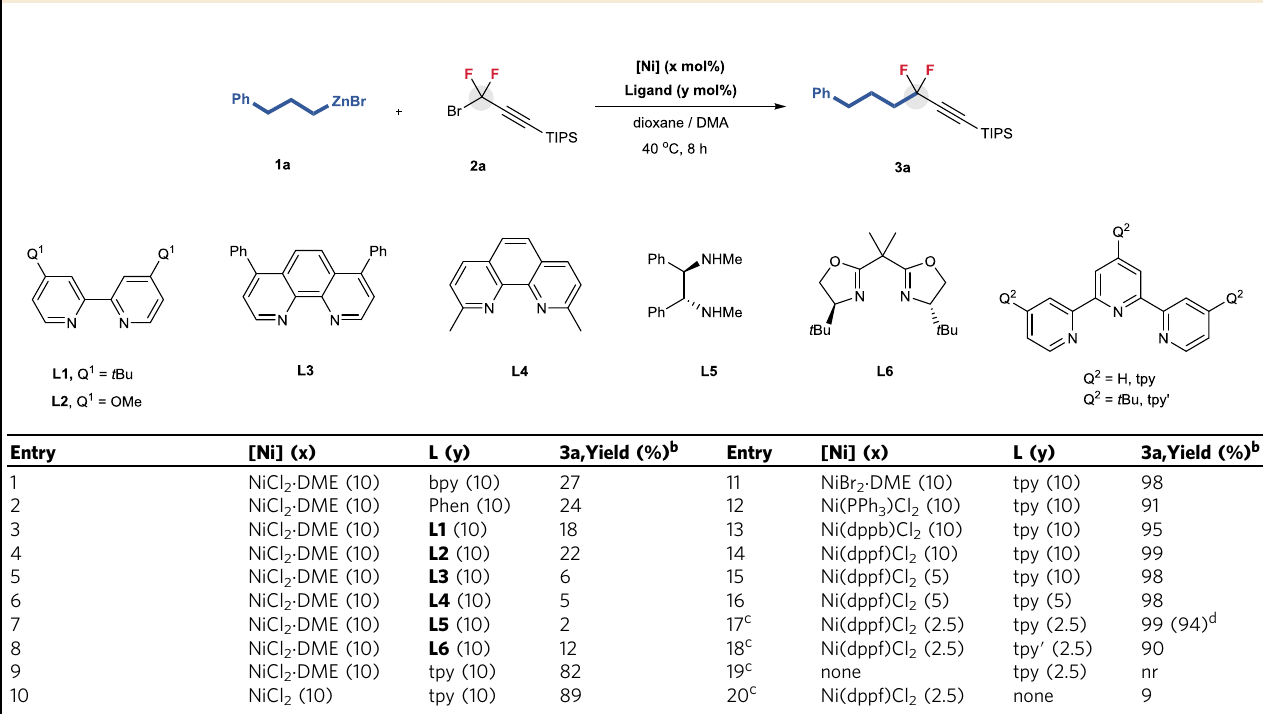
Table 1 Representative results for optimization of Ni-catalyzed cross-coupling of 1a with 2a